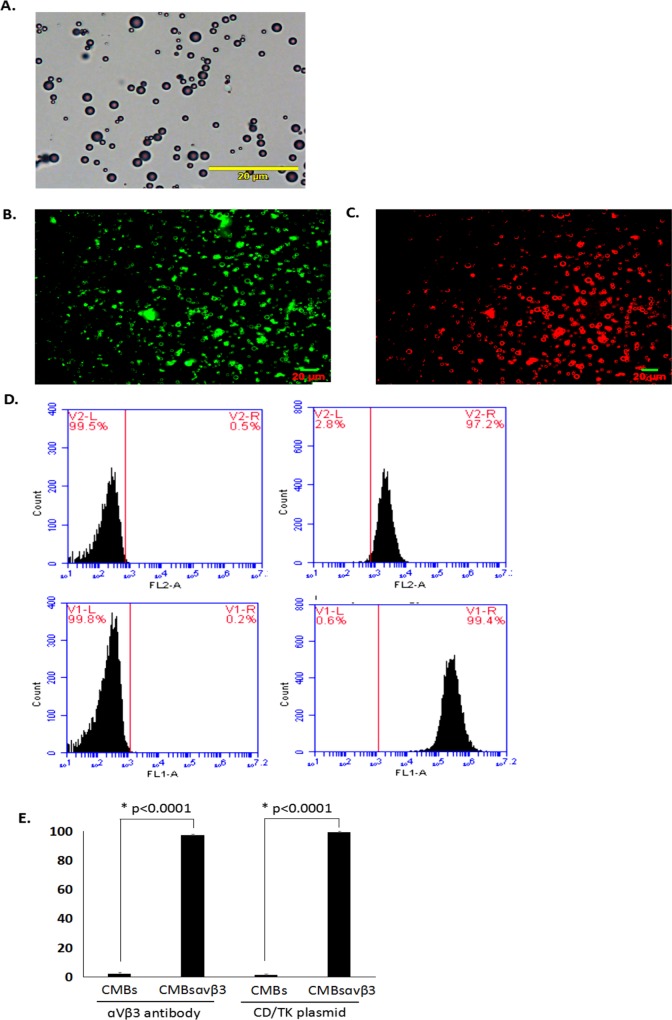
Morphology and fluorescence image of CMBsαvβ3.A. Under light microscopy (magnification, x400), microbubbles were uniformly distributed with no visible aggregation. Each photo is representative of three experiments. B. Green fluorescence was observed on the surface of CMBsαvβ3 using immunofluorescent microscopy. Each photo is representative of three experiments. C. Red fluorescence was observed on the surface of CMBsαvβ3 using immunofluorescent microscopy. Each photo is representative of three experiments. D. Flow cytometry analysis of the αvβ3 antibody and plasmid combined to CMBsαvβ3 or CMBs. Each histogram is representative of three experiments. E. Comparison of the αvβ3 antibody and plasmid binding efficiencies in cells treated with CMBsαvβ3 or cells treated with CMBs (mean ± SD of three experiments; p < 0.0001).